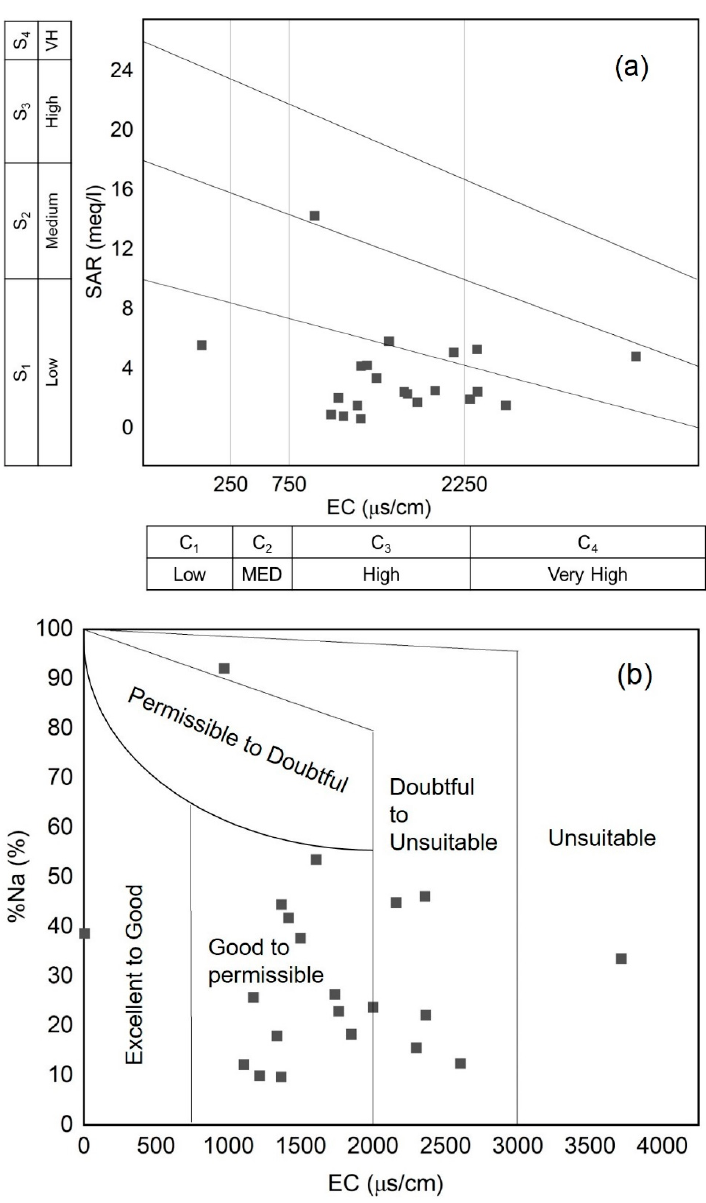
Figure 5. ( a ) USSL diagram and ( b ) Wilcox diagram showing the irrigation water quality classifica-